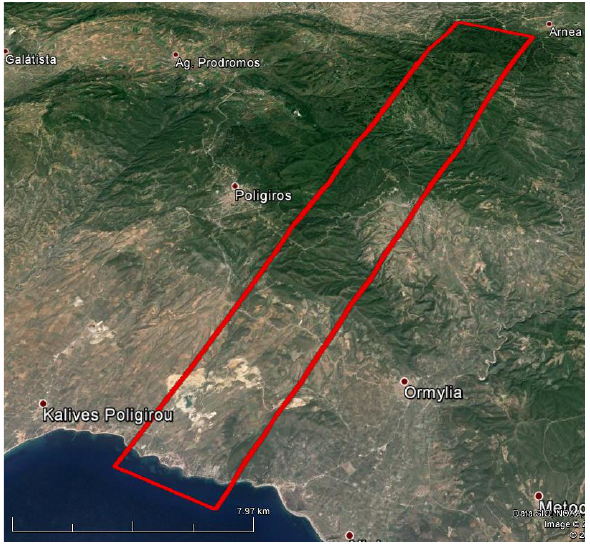
Figure 2. The geographical location of the study area.